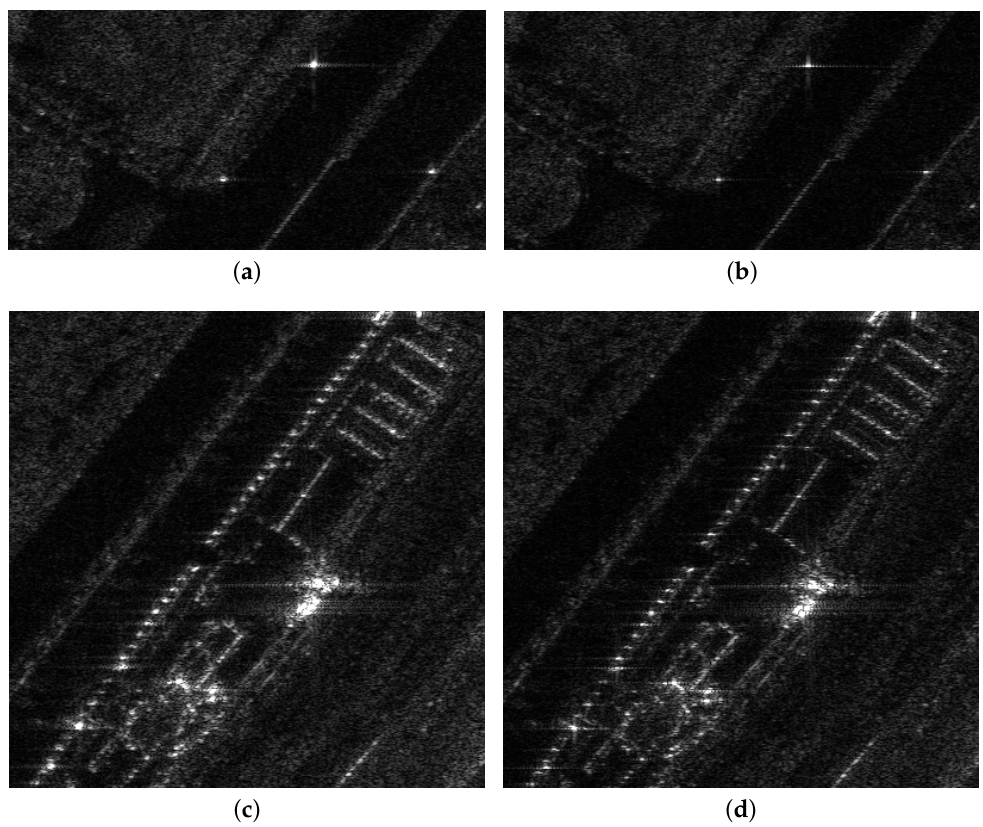
Figure 13. The imaging result of local area A based on ( a , c ) start-stop model and ( b , d ) non-start-stop